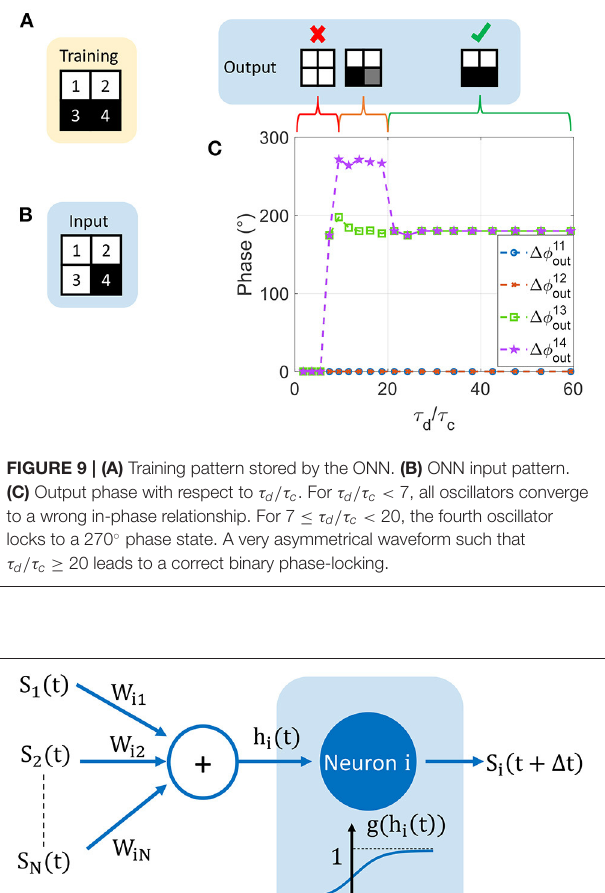
parameter sets the range of R C and could be adapted for different ONN sizes. Interestingly, we notice that | 1 W 21 /1 R C | is quite large for a positive weight, whereas it is much smaller for a negative one. For example, we see in Figure 11B that the function ζ − 1 is a logarithmic function; thus, any small variation in 1 R C around 10k (cid:127) is likely to change the final phase state